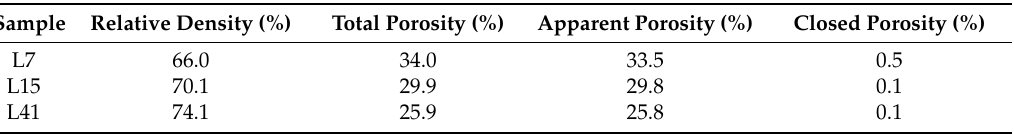
Table 1. The relative densities and porosities of porous L-SiC ceramics with different particle sizes of initial coarse SiC